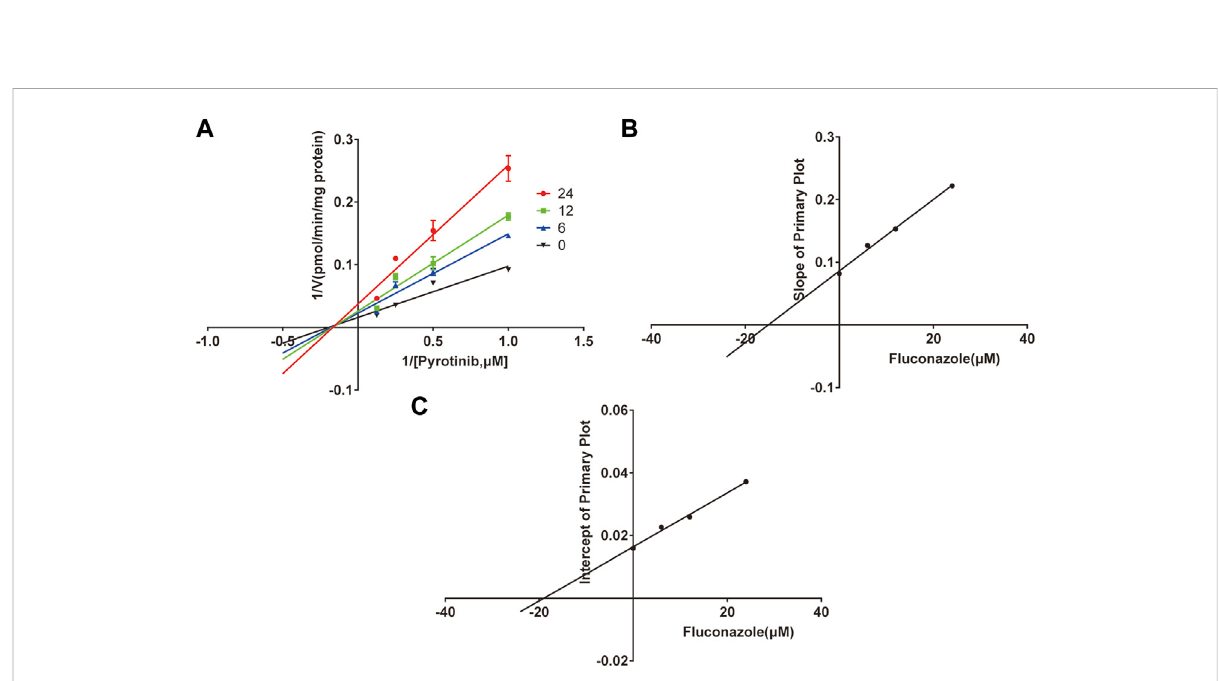
FIGURE 6 The Primary Lineweaver-Burk plots of fl uconazole inhibition on pyrotinib (A) ; Slope of the primary plot of fl uconazole (B) ; Intercept of the primary plot of fl uconazole (C) (values are means ± standard deviations, n =3).